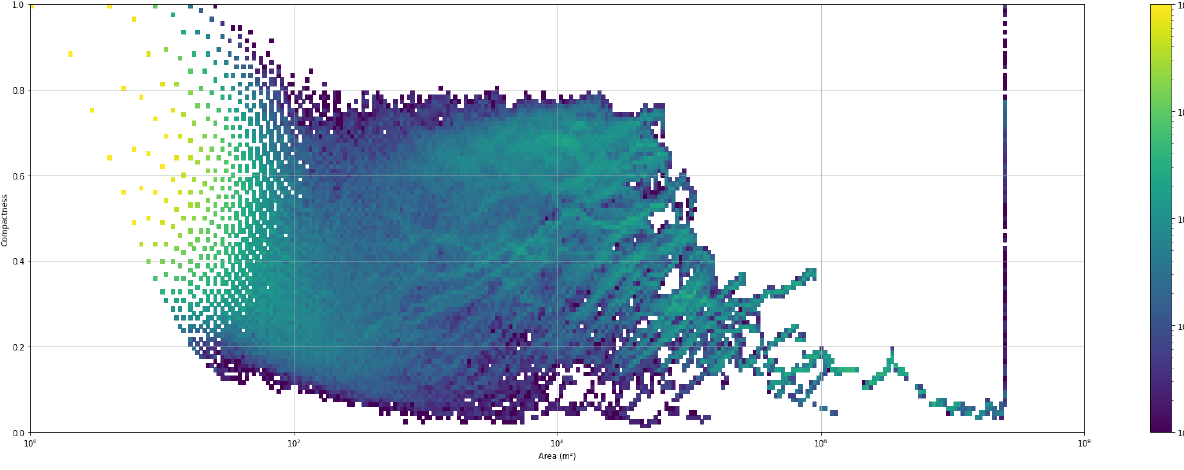
Figure 2. Pattern spectrum (area and compactness) of the DTM with the